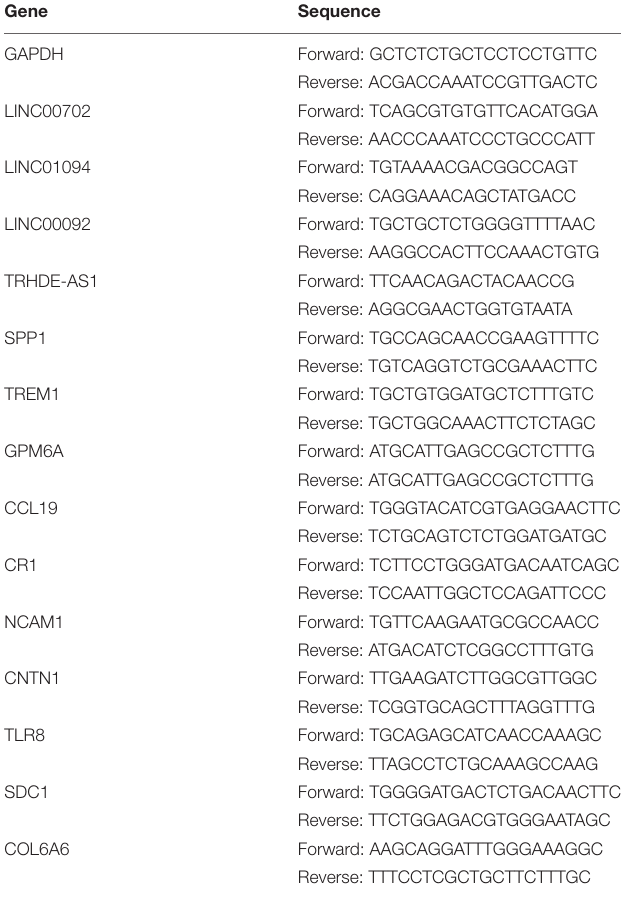
TABLE 1 | List of primer sequences used for qRT-PCR.